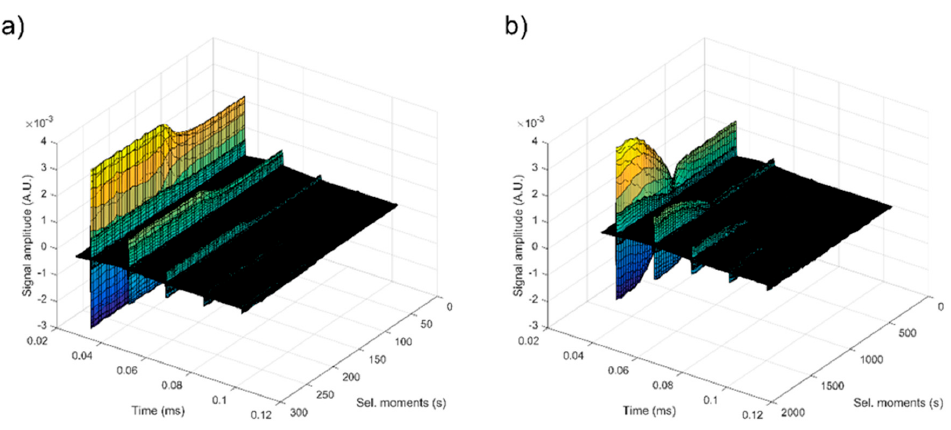
Figure 2. The recorded signals of samples S1 ( a ) and S2 ( b ).